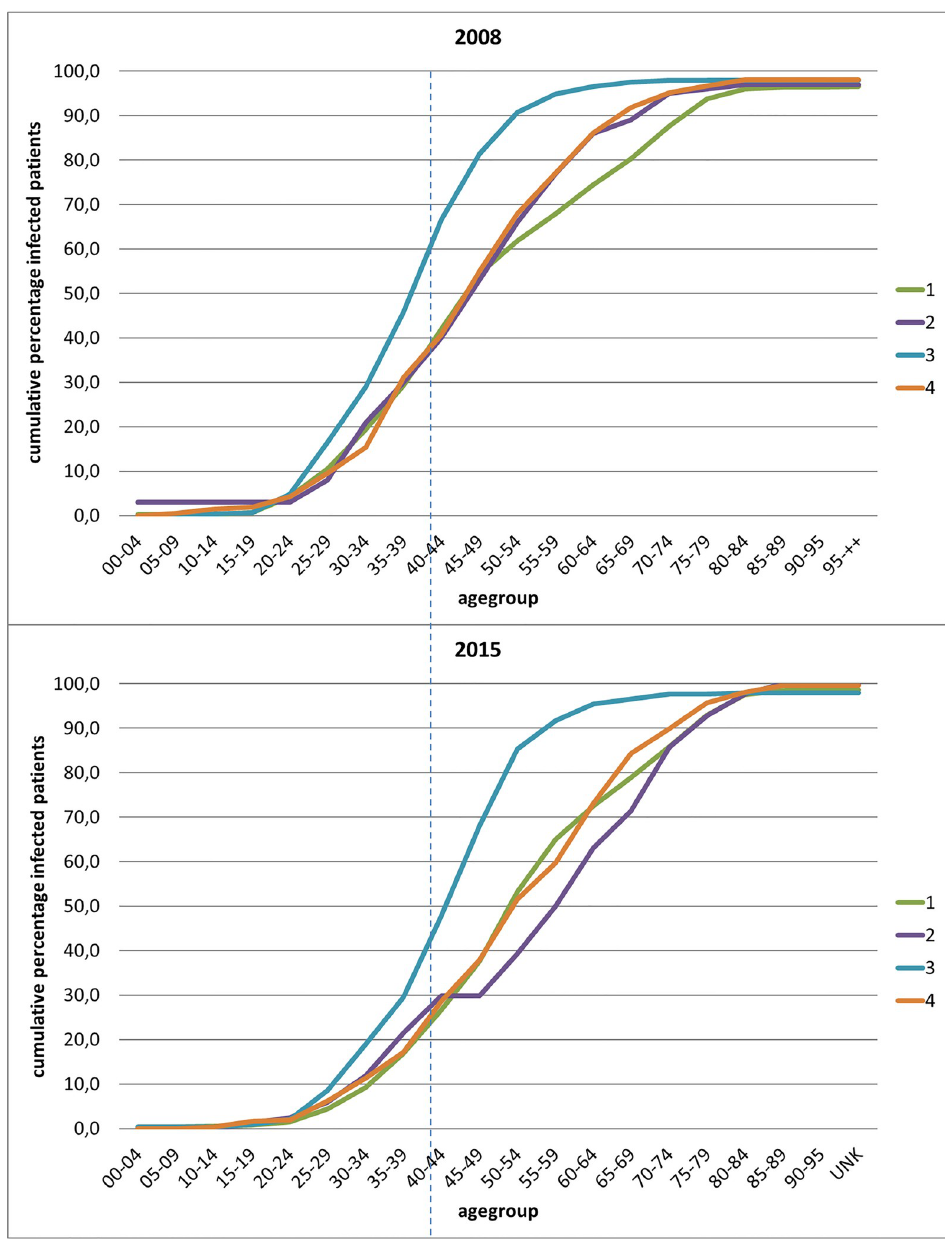
Fig 4. Cumulative percentage of infected patients for the different age groups and genotypes 1–4 at the time point 2015 as compared to 2008. The dashed line represents an imaginary line reaching the age of 40 years to demonstrate the shift in age groups between 2008 and